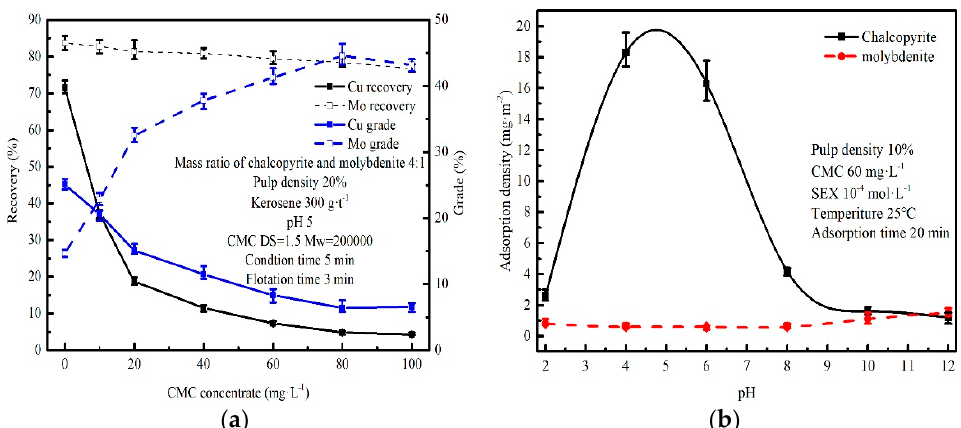
Figure 3. ( a ) Effect of CMC concentration on the Cu–Mo mixed minerals separation flotation; ( b ) adsorption of CMC on the chalcopyrite and molybdenite.